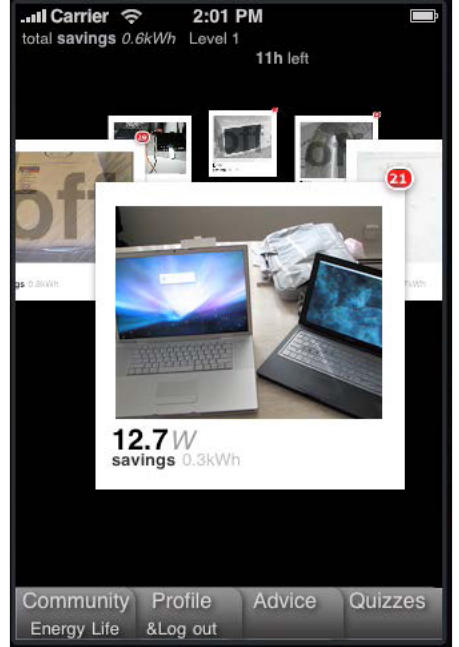
Figure 11. The main screen of EnergyLife game showing a carusel of cards, each related to an energy- consuming device. Image from Reference [49].